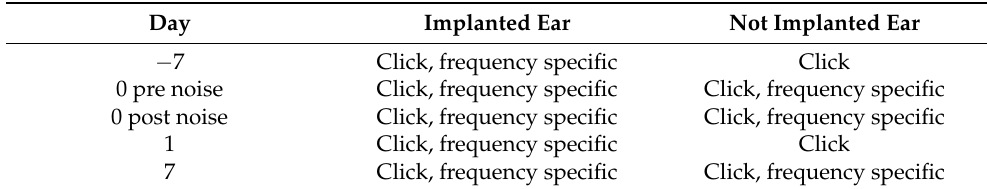
Table 1. Overview of the time points and scope of the ABR measurements for implanted and contralateral ears. Frequency-specific measurements included the frequencies 500 Hz, 1, 2, 4, 8, 16, 32, and 40